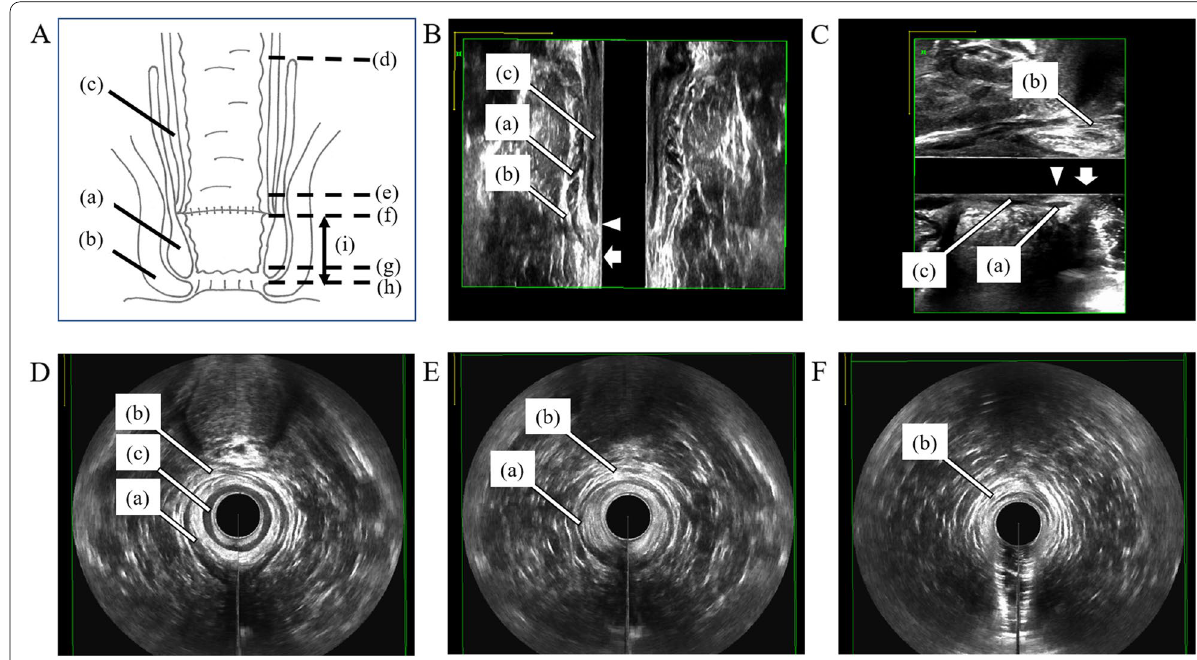
Fig. 1 A Schema of the coronal view. a Internal anal sphincter muscle (IAS). b External anal sphincter muscle (EAS). c Smooth muscle of the pull-through bowel. (d) The edge of the residual rectal muscular cuff. e Anorectal line. f The anastomosis. g The dentate line. h The intersphincteric groove. i Distance between the anastomosis and intersphincteric groove (DBAI). B Coronal view of 3D-EAUS ( a ) IAS and ( c ) smooth muscles are low echoic, and ( b ) EAS is high echoic. The distal edge of the ( c ) smooth muscle is the anastomosis (arrowhead) and the boundary between ( a ) IAS and ( b ) EAS is the intersphincteric groove (arrow). C Sagittal view of 3D-EAUS. The distal edge of the ( c ) smooth muscle is the anastomosis (arrowhead) and the boundary between ( a ) IAS and ( b ) EAS is the intersphincteric groove (arrow). D Axial view of 3D-EAUS between ( d ) and ( f ). Double low echoic circle are shown as a target sign because both ( a ) IAS and ( c ) smooth muscle are low echoic and ( b ) EAS is high echoic. E Axial view of 3D-EAUS between ( f ) and ( h ). Because there is no smooth muscle of the pull-through bowel, low echoic circle, ( a ) IAS, is single. F Axial view of 3D-EAUS below ( h ). Because there is no IAS, only high echoic circle, ( b ) EAS, is